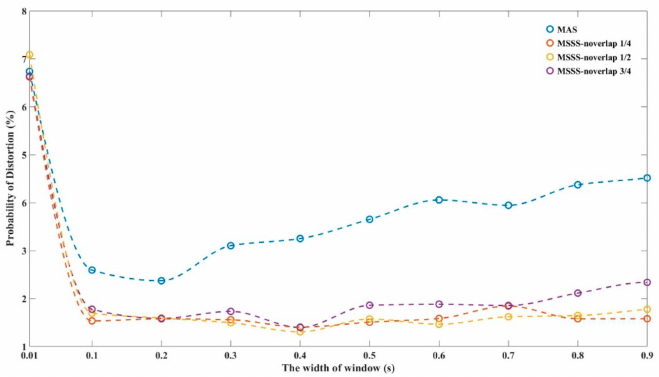
Figure 11. The probability of failure for different window